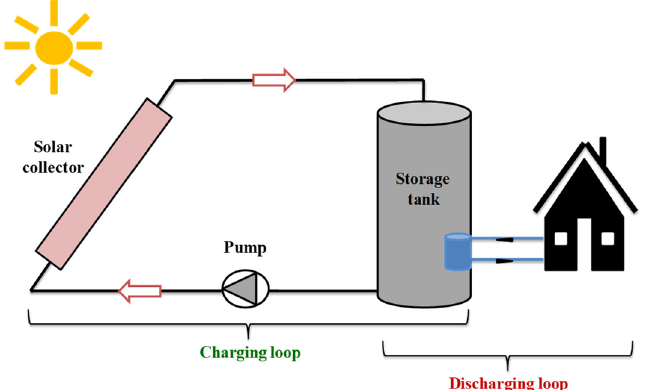
Figure 5. Simple solar application: solar-based water heating device, reprinted/adapted with permission from Ref. [3], 2022, Springer Nature. Table 3. SHS techniques and their classification, reprinted/adapted with permission from Ref. [38], 2022, Elsevier.